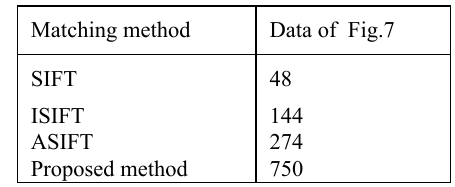
Table 1. Statistical results of SIFT, ISIFT, ASIFT and Proposed